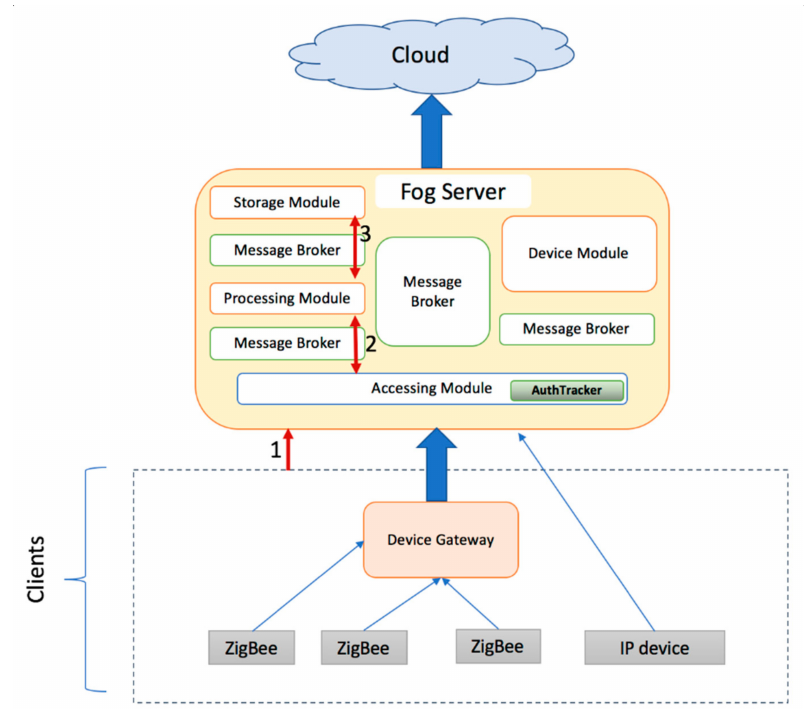
Figure 7. Data uploading